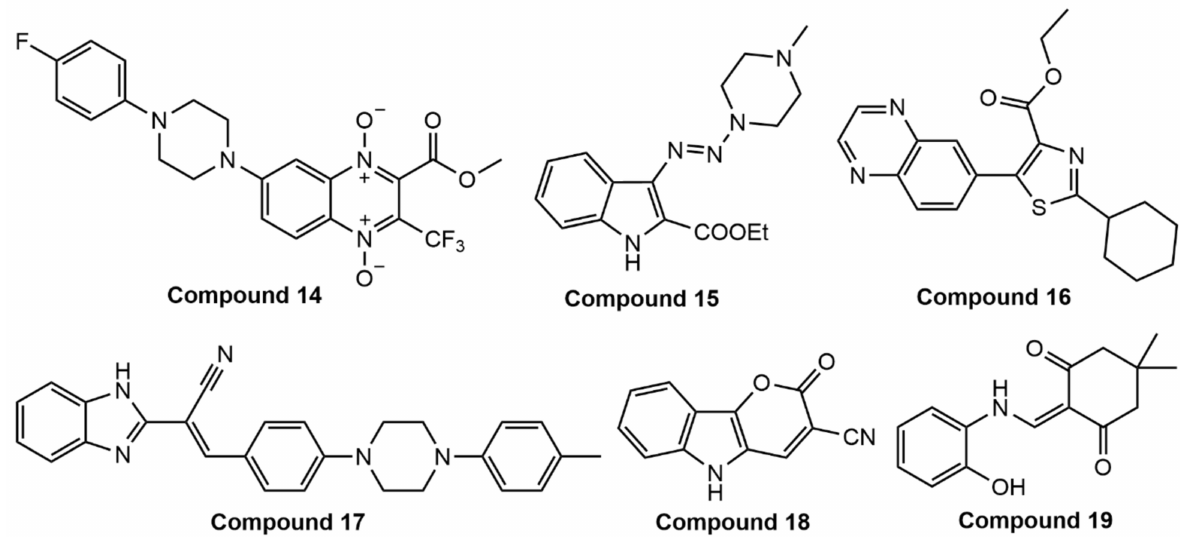
Figure 2. Small molecules active against dormant M. tuberculosis by an unknown mechanism of action. Com- pound 14: 6-(4-(4-fluorophenyl)piperazin-1-yl)-3-(methoxycarbonyl)-2-(trifluoromethyl)quinoxaline 1,4-dioxide; com- pound 15: ethyl ester of 3-((4-methylpiperazin-1-yl)diazenyl)-1 H -indole-2-carboxylic acid; compound 16: ethyl ester of 2-cyclohexyl-5-(quinoxalin-6-yl)thiazole-4-carboxylic acid; compound 17: 2-(1 H -benzo[d]imidazol-2-yl)-3-(4-(4-(p- tolyl)piperazin-1-yl)phenyl)acrylonitrile; compound 18: 2-oxo-2,5-dihydropyrano[3,2- b ]indole-3-carbonitrile; compound 19: